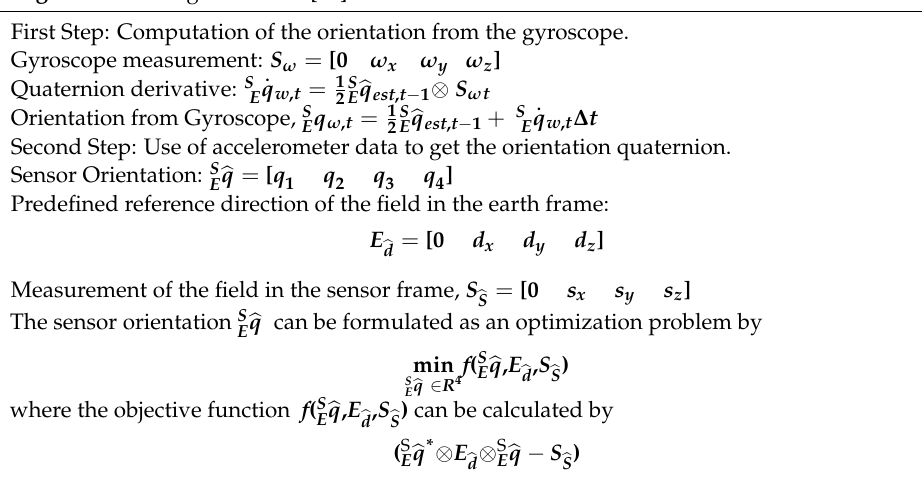
Algorithm 2 Madgwick Filter